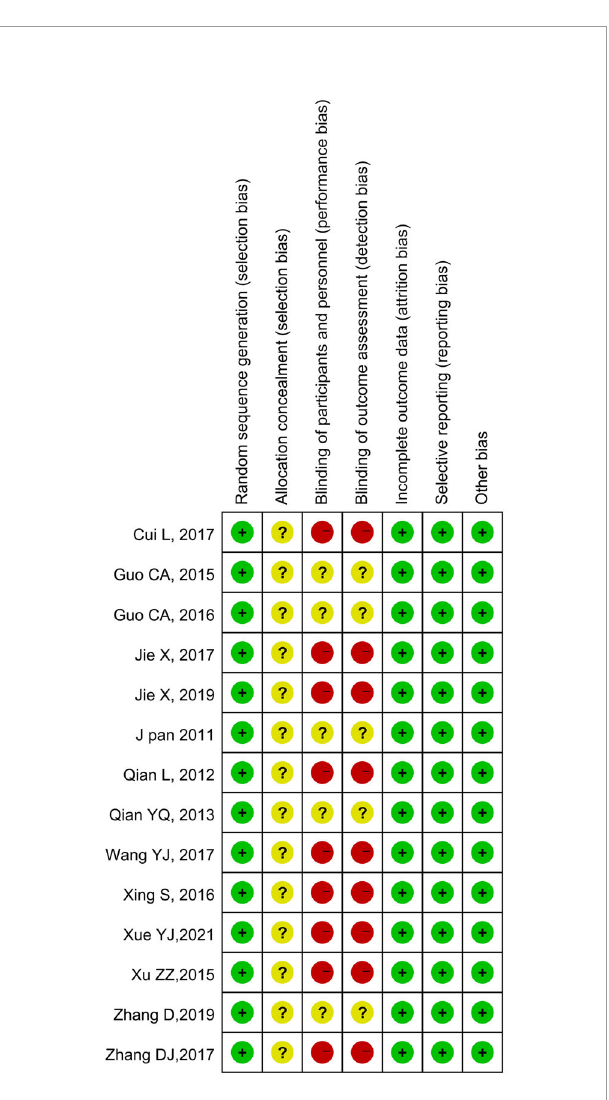
FIGURE 3 | Risk of bias summary. Green indicates low risk; red indicates high risk; yellow indicates unknown